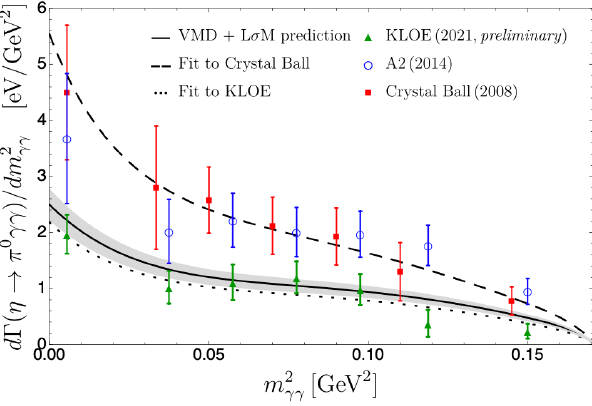
Figure 3. KLOE (green triangles), A2 (blue circles) [12] and Crystal Ball (red squares) [13] measure- ments of the m 2 spectrum for the η → π 0 γγ decay, as well as the SM prediction [3] (solid black line) γγ and SM with B -boson predictions using the fitted parameters from Eqs. (7) and